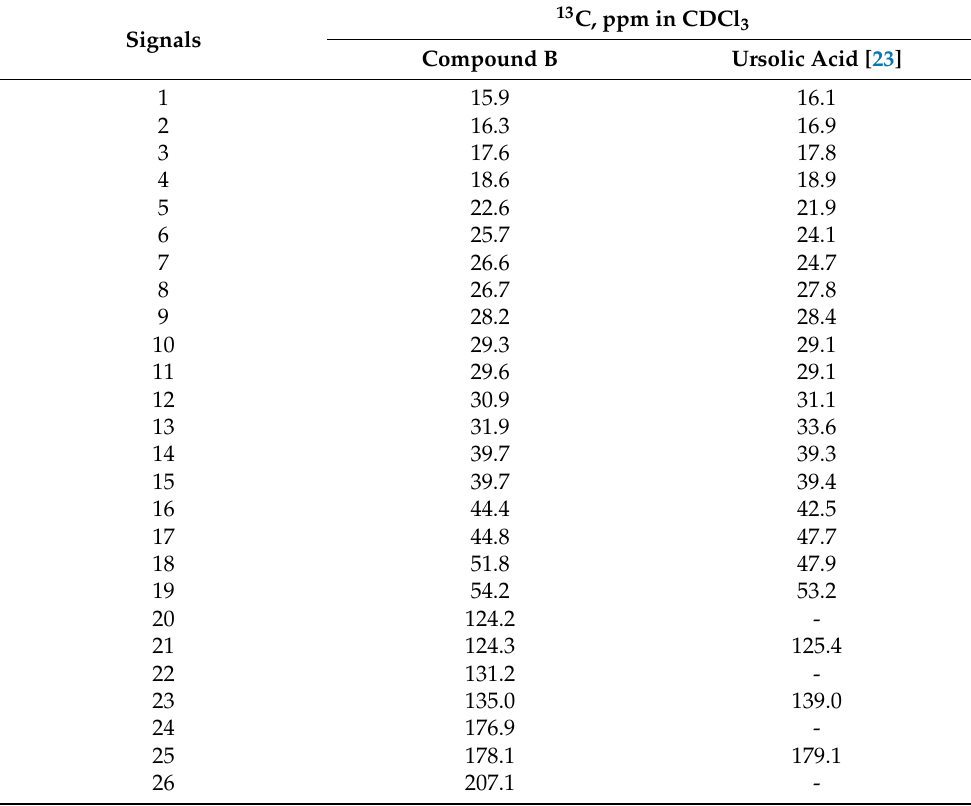
Table 9. 13 C-NMR spectral data of compound B showing similarities with the reported literature data